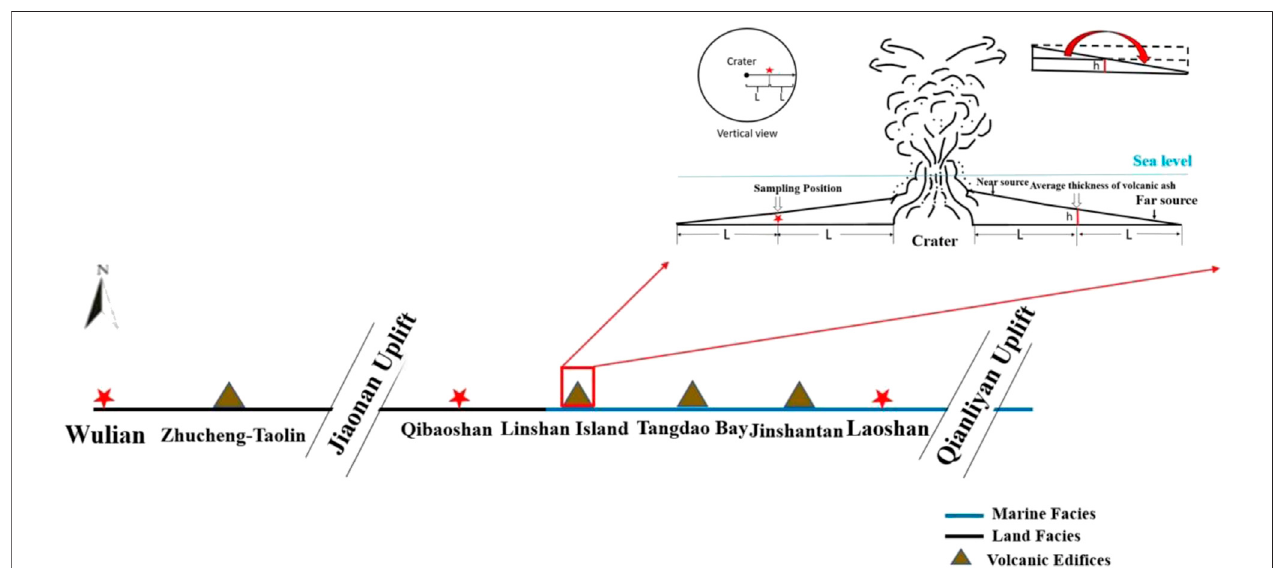
FIGURE 9 | Volcanic edi fi ce diagram of Lingshan Island and the offshore area in eastern Shandong Province.